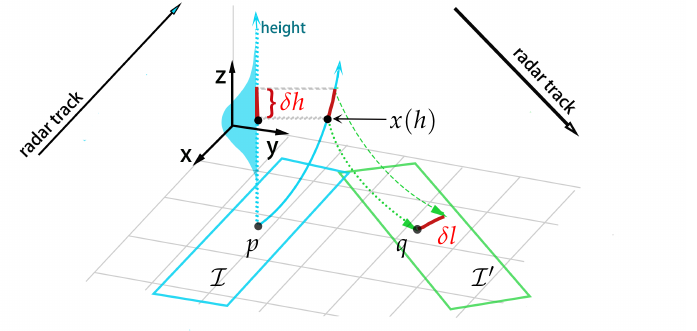
Figure 2. Schematic of a two-view stereo SAR configuration; I is the reference image and I (cid:48) is a slave